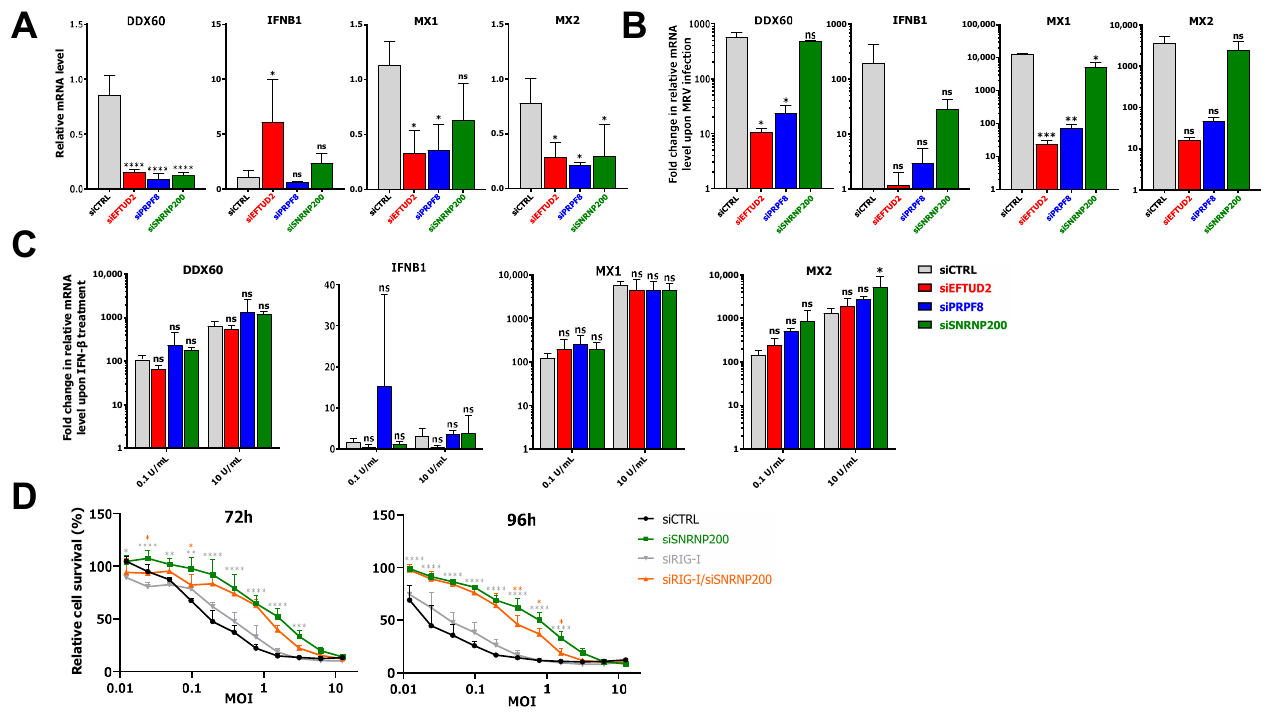
Figure 5. EFTUD2 and PRPF8 control the interferon response during MRV infection. ( A ) Relative mRNA levels for DDX60, IFNB1, MX1, and MX2 in control or EFTUD2, PRPF8, or SNRNP200- depleted L929 cells. L929 cells were transfected with the appropriate siRNA for 72 h before RNA was harvested, reverse transcribed, and subjected to qPCR. PSMC4, PUM1, and TXNL4B were used as housekeeping genes for normalization. n = 3, biological replicates, one-way ANOVA with Dunnett’s multiple comparisons test against the control siRNA condition (ns, p > 0.05; *, p ≤ 0.05; ****, p ≤ 0.0001). ( B ) Relative fold induction upon MRV infection for DDX60, IFNB1, MX1, and MX2 in control or EFTUD2, PRPF8, or SNRNP200-depleted L929 cells. L929 cells were transfected with the appropriate siRNA for 55 h before being either mock-infected or infected with MRV at a MOI of 3 for 24 h. Each replicate was arbitrarily attributed an uninfected control sample to calculate a fold- change upon infection. n = 3, biological replicates, Brown-Forsythe and Welch one-way ANOVA with Dunnett’s T3 multiple comparisons test against the control siRNA condition (ns, p > 0.05; *, p ≤ 0.05; **, p ≤ 0.01; ***, p ≤ 0.001). ( C ) Relative fold induction upon IFN- β treatment for DDX60, IFNB1, MX1, and MX2 in control or EFTUD2, PRPF8, or SNRNP200-depleted L929 cells. L929 cells were transfected with the appropriate siRNA for 72 h, and then IFN- β was added for 5 h before RNA was harvested, reverse transcribed and subjected to qPCR. PSMC4, PUM1, and TXNL4B were used as housekeeping genes for normalization. n = 3, biological replicates, two-way ANOVA with Š í d á k’s multiple comparisons test against the control siRNA treated with the same IFN- β concentration (ns, p > 0.05; *, p ≤ 0.05). ( D ) Methylene blue staining of control, SNRNP200, RIG-I, or RIG-I/ SNRNP200-depleted L929 cells infected with 1:1 dilutions of MRV at 72 h or 96 h post-infection. Twice the quantity of siRNA was transfected to perform DKD; in the case of single KD, siCTRL was added to match the total siRNA quantity of the DKD. The quantification of cell-bound methylene blue stain is shown for three independent experiments. n = 3, biological replicates, two-way ANOVA with Dunnett’s multiple comparisons test against the SNRNP200 KD condition (in red; *, p ≤ 0.05; **, p ≤ 0.01; ***, p ≤ 0.001; ****, p ≤ 0.0001). If not indicated, results are not statistically significant. The results of the comparison against the control siRNA (in black) are not indicated for clarity